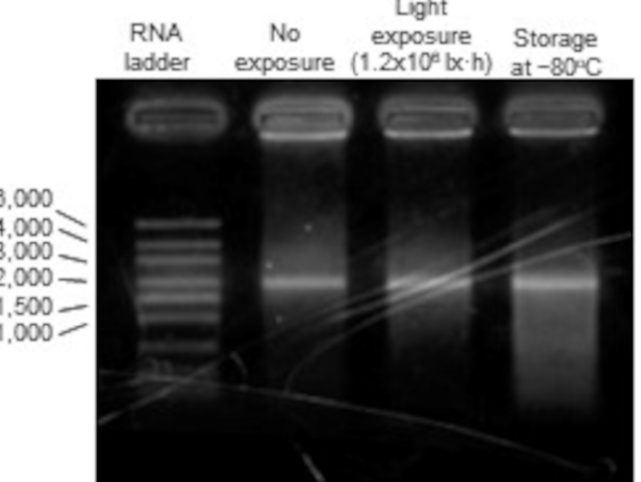
Figure 6. Agarose gel electrophoresis for mRNA inside LNP. Polyoxyethylene(10) octylphenyl ether